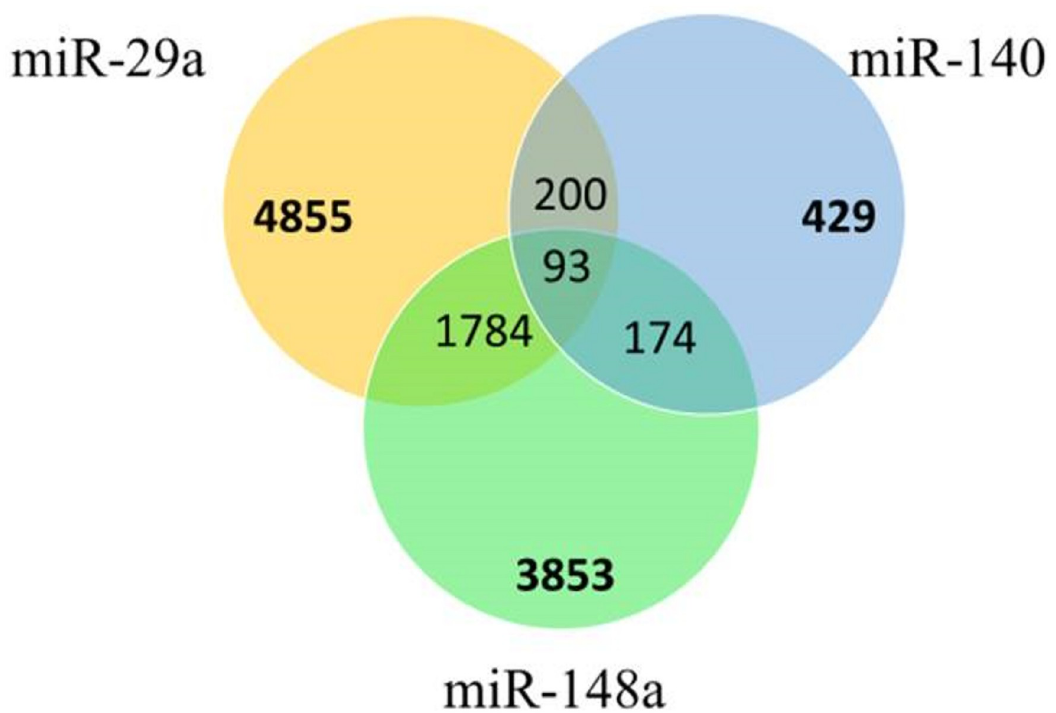
Fig 1. Venn diagram displaying the number of differentially overlapping predicted target genes between miR-29a, miR-140, and miR-148a.